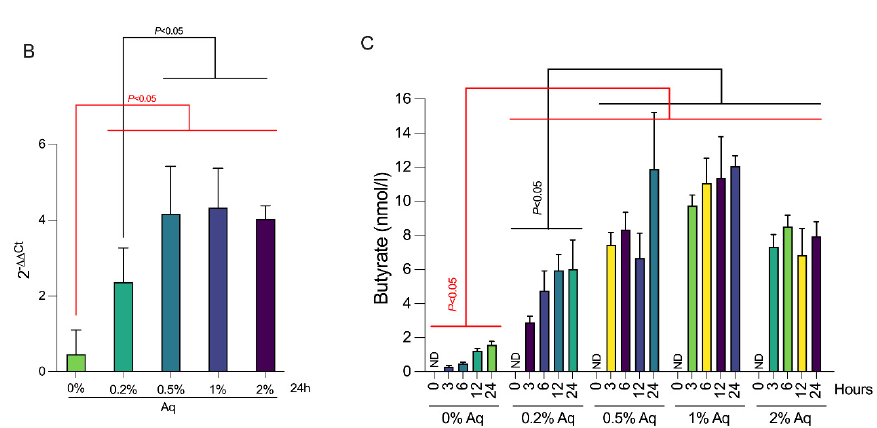
Figure 1. The impact of Aq on F. prausnitzii growth and butyrate production at concentrations of 0.2, 0.5, 1, and 2% to investigate the growth stimulatory effect. The impact on growth was quantified by measuring the absorbance at 600 nm for 24 h at 2 h intervals. Panel ( A ), butyryl-CoA transferase ( But ) gene was quantified from the total bacteria in minimal media at 24 h. The However, gene was quantified using 2 CT analysis and results are expressed as mean SEM (standard error of mean). Student t test was used to identify significance at values below P < 0.05 (Panel ( B )). Panel ( C ) shows the amount of butyrate released by F. prausnitzii in minimal media at 0.2%, 0.5%, 1% and 2% Aq and at intervals of 0, 3, 6, 12 and 24 h. All experiments were performed triplicate and each measurement was performed from three separate samples. A P value less than 0.05 was considered significant.